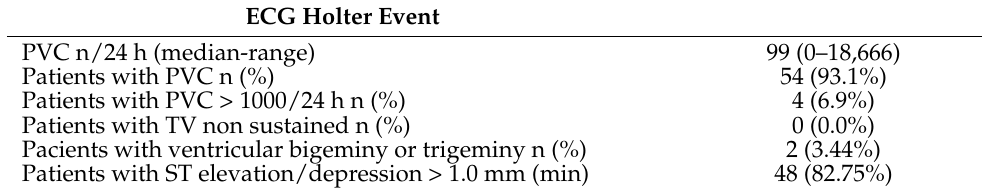
Table 3. Ventricular ectopic and ST segment events recorded on Holter ECG.